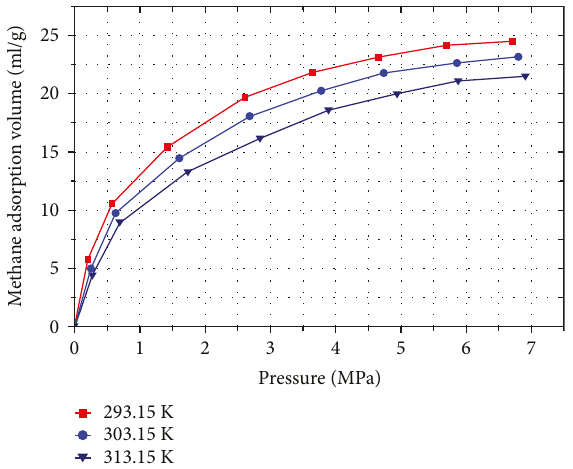
Figure 2: Adsorption isotherms of methane at di ff erent